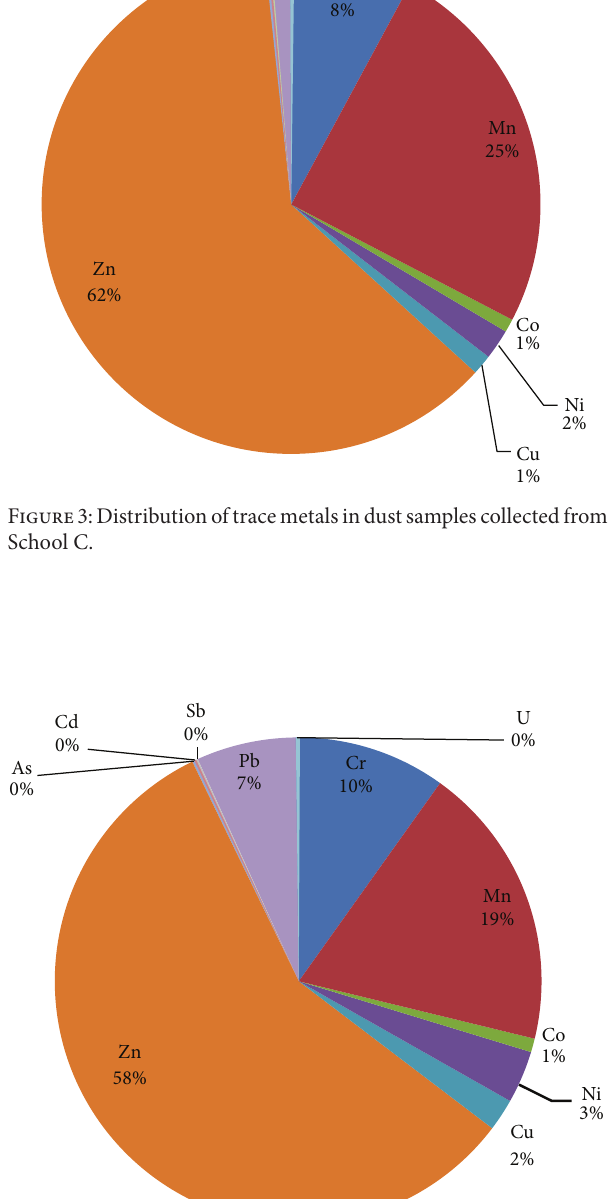
Figure2:Distributionoftracemetalsindustsamplescollectedfrom School B.